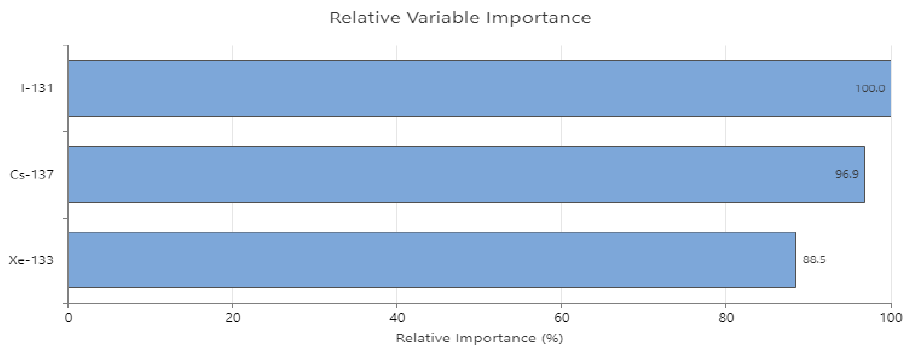
Figure 3. Graph showing relative importance of predictors in January (winter).